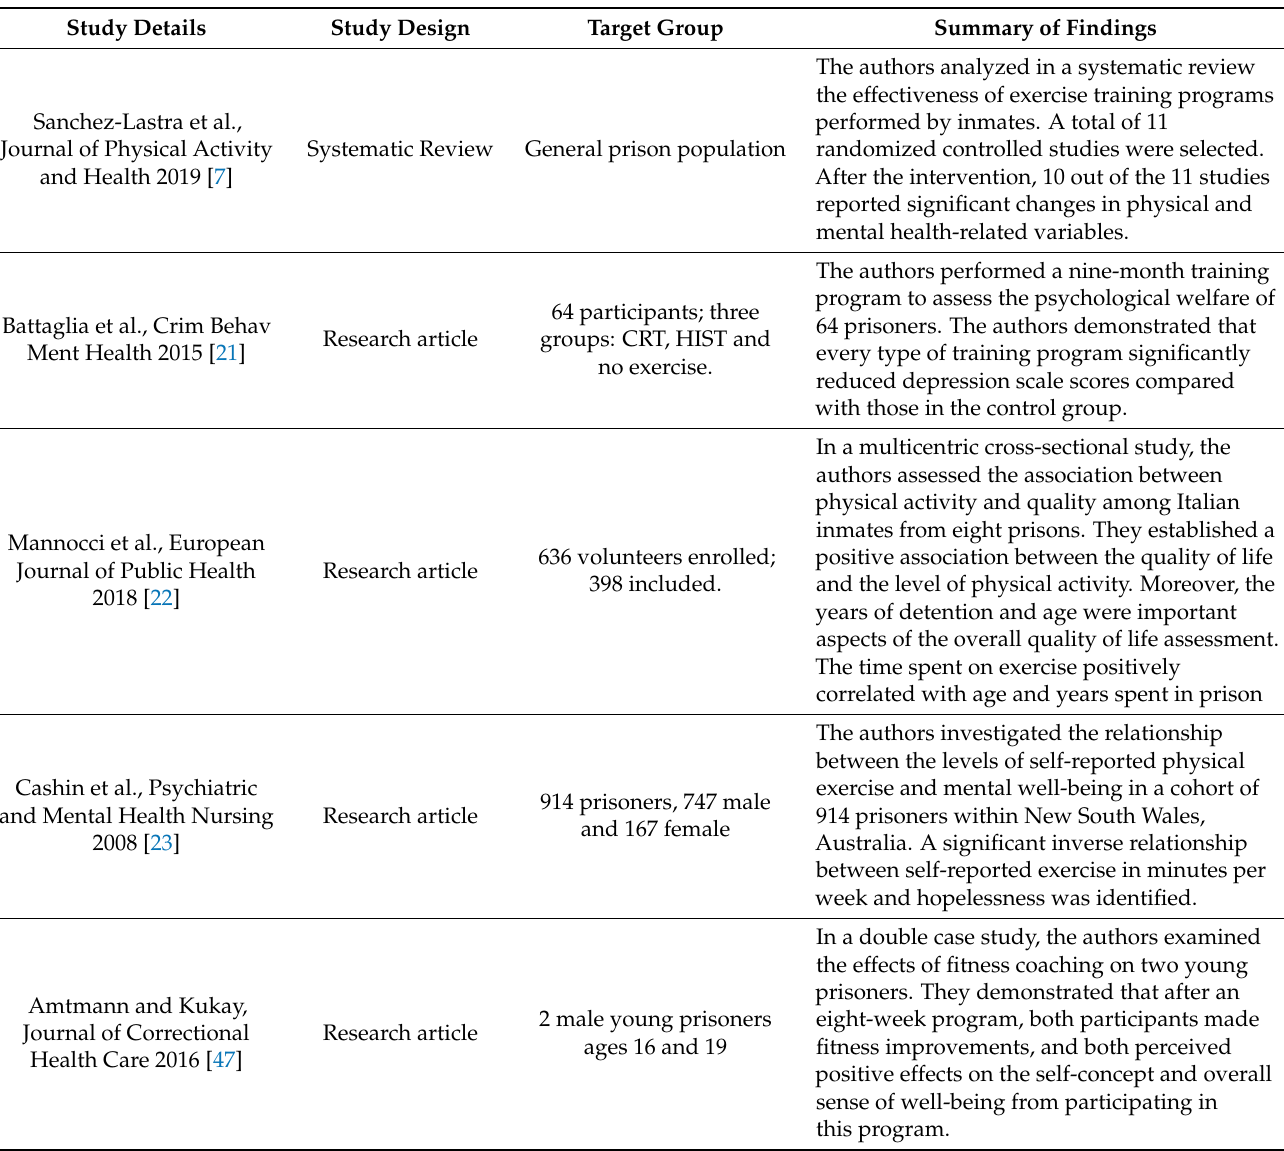
Table 4. Summary of the finding of the ten studies evaluating the feasibility and the effectiveness of exercise programs in